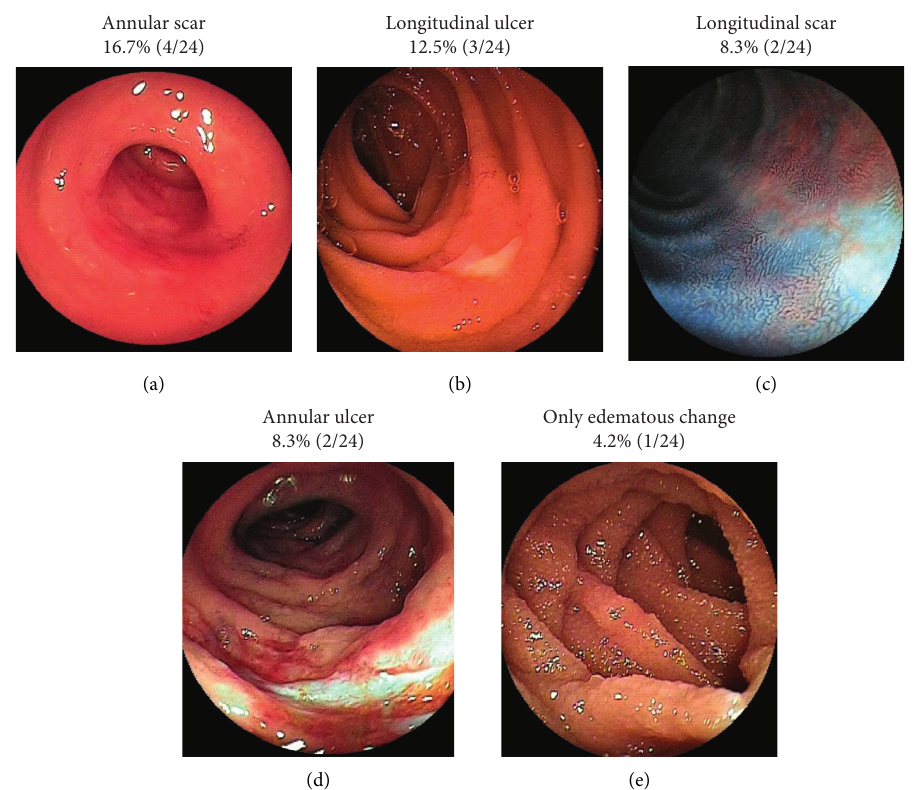
Figure 4: Endoscopic images in the small bowel, excluding the stenosis site, during double-balloon endoscopy.